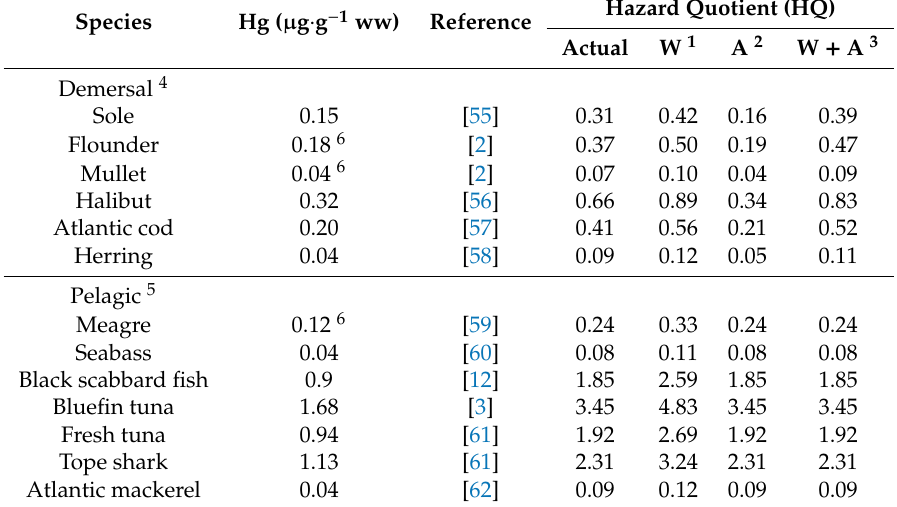
Table 3. Mercury average concentrations (Hg, µ g · g − 1 ww) of demersal and pelagic species